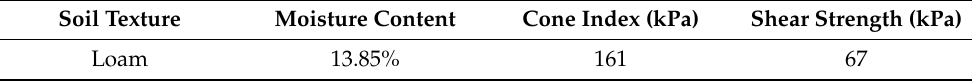
Table 3. Soil properties of the experimental soft soil ground.